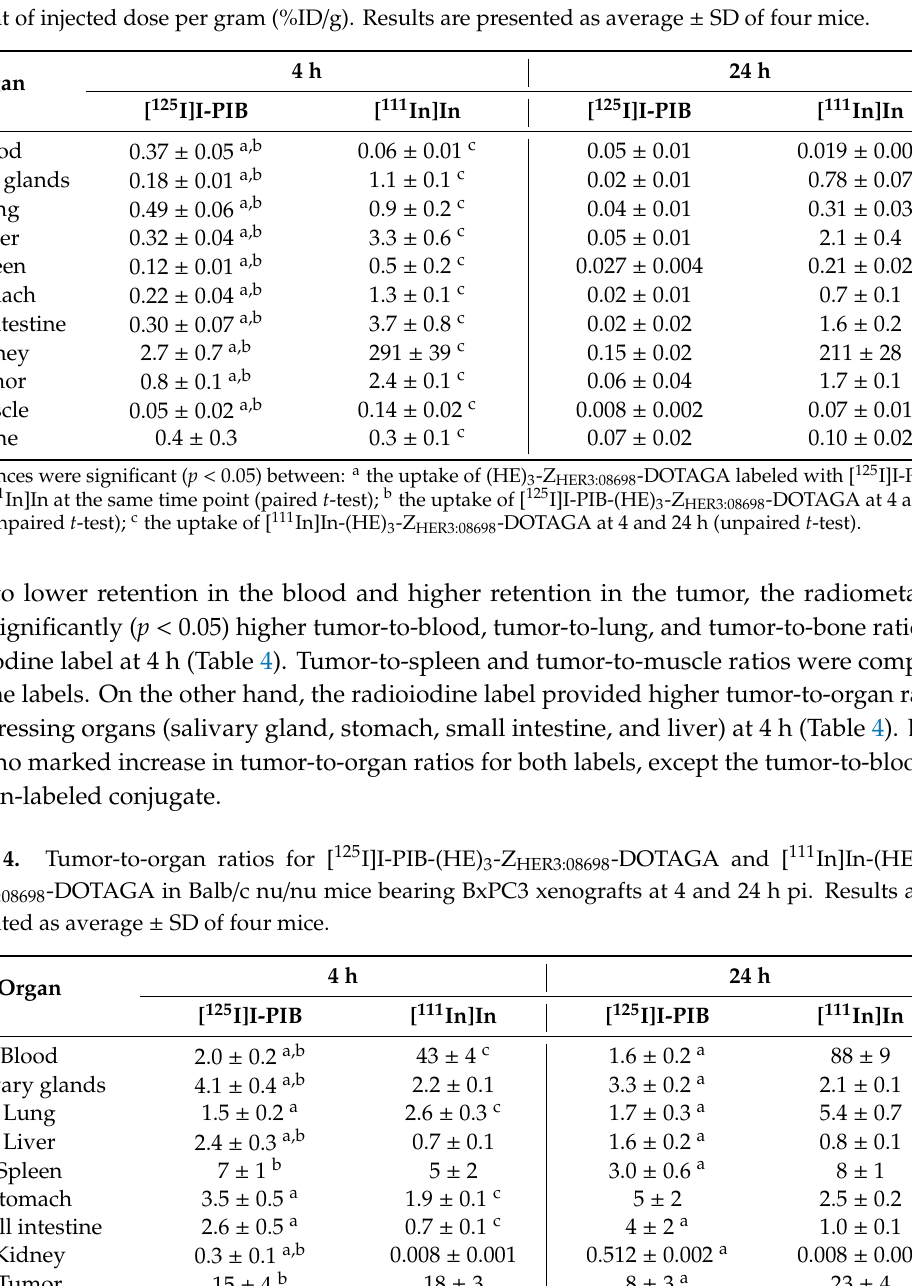
Table 3. Biodistribution of [ 125 I]I-PIB-(HE) 3 -Z HER3:08698 -DOTAGA and [ 111 In]In-(HE) 3 -Z HER3:08698 - DOTAGA in Balb / c nu / nu mice bearing BxPC3 xenografts at 4 and 24 h pi. Uptake is presented as